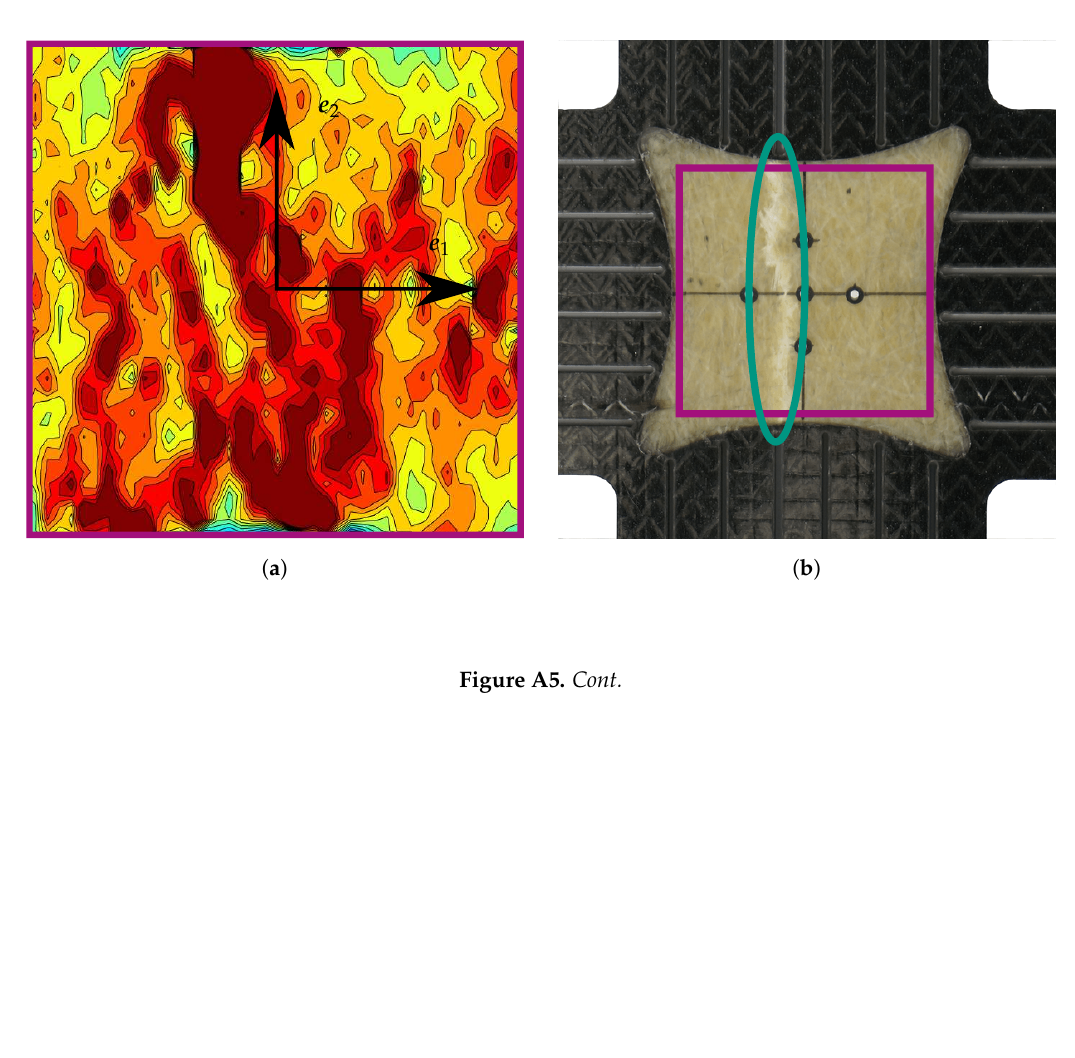
Figure A4. Continuous fiber specimen arms, geometry 1. Last image of strain field before failure and failed specimen. ( a ) strain field ε 11 in A I for load case P Γ = 0 ; ( b ) failed specimen for load case P Γ = 0 ; ( c ) strain field ε 11 in A I for load case P Γ = 1 ; ( d ) failed specimen for load case P Γ = 1 .